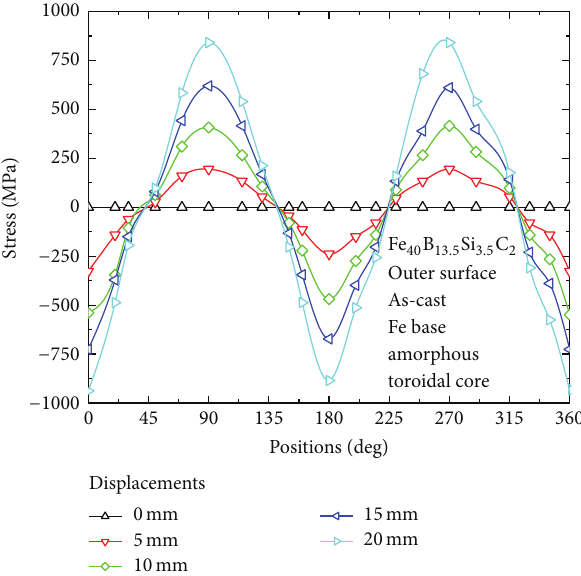
Figure 11: Stress distribution on the outer surface, around the circumference of the as-cast, Fe based, 0.5 mm thick, and 30 mm inner diameter amorphous toroidal transducer